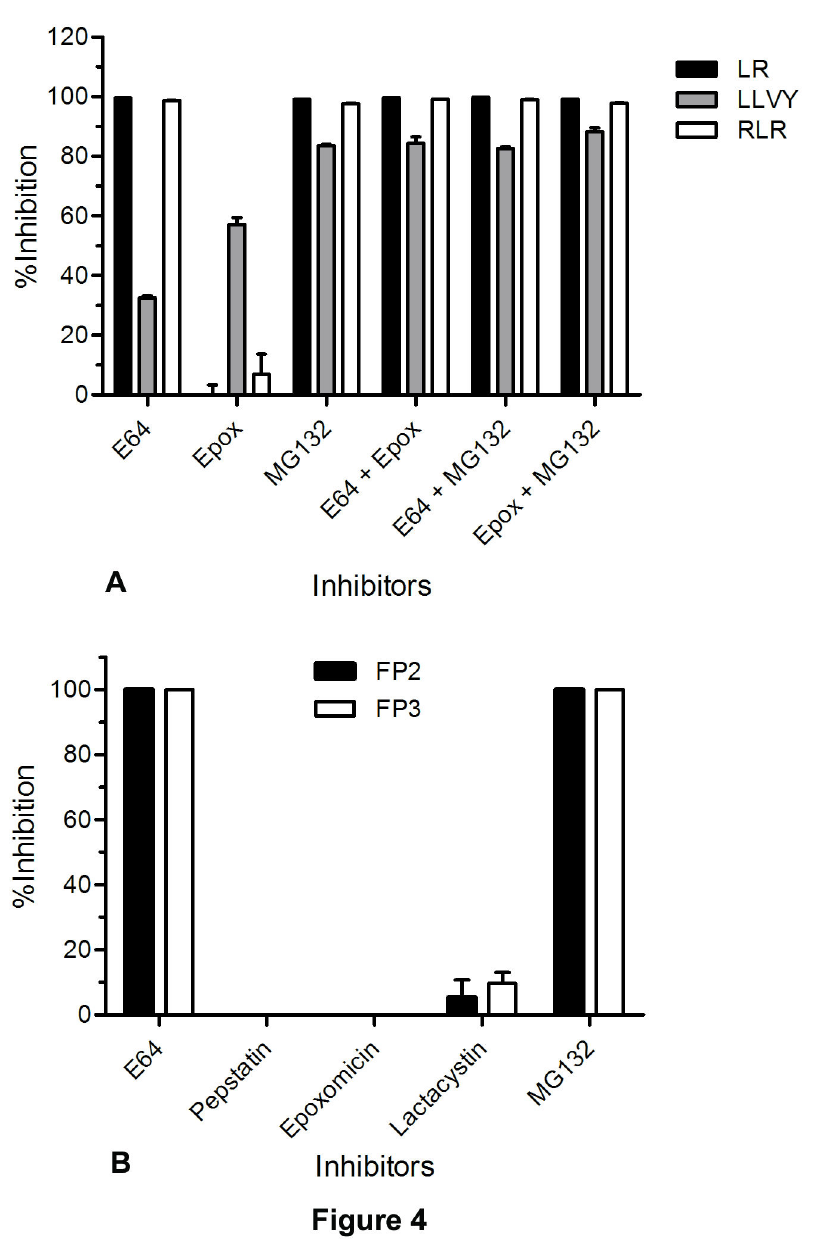
Figure 4. Inhibition of cysteine protease and proteasome activities by MG132. A . Inhibition of total soluble extracts of